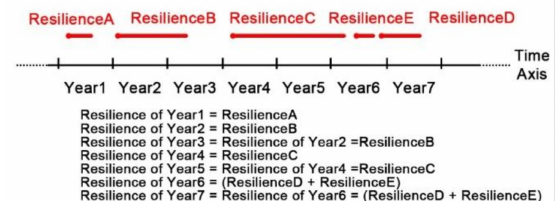
Figure 2. The rule of annual terrestrial resilience calculation. The red dot is the start point of recovery and the red line is the recovery time. The red “Resilience” is the resilience value calculated from LAI